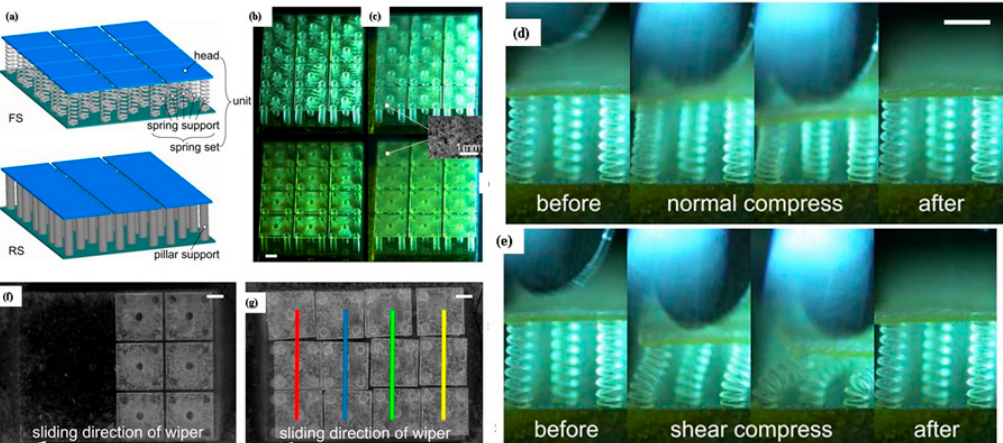
Figure 11. ( a ) Design of flexible and rigid singly re-entrant mushroom-like structure, ( b , c ) optical microstructure of corresponding surfaces using 3-D projection micro-stereolithography, ( d , e ) optical microscopy entails the mechanical robustness of mushroom-like flexible units against normal and shear compress, and ( f , g ) mechanical robustness of mushroom-like units against rigid and flexible surface after friction under 4 N (vertical lines resembling the similar behavior of FS and RS). Therefore, mushroom-like flexible structures are preferable for better tribology properties [237].